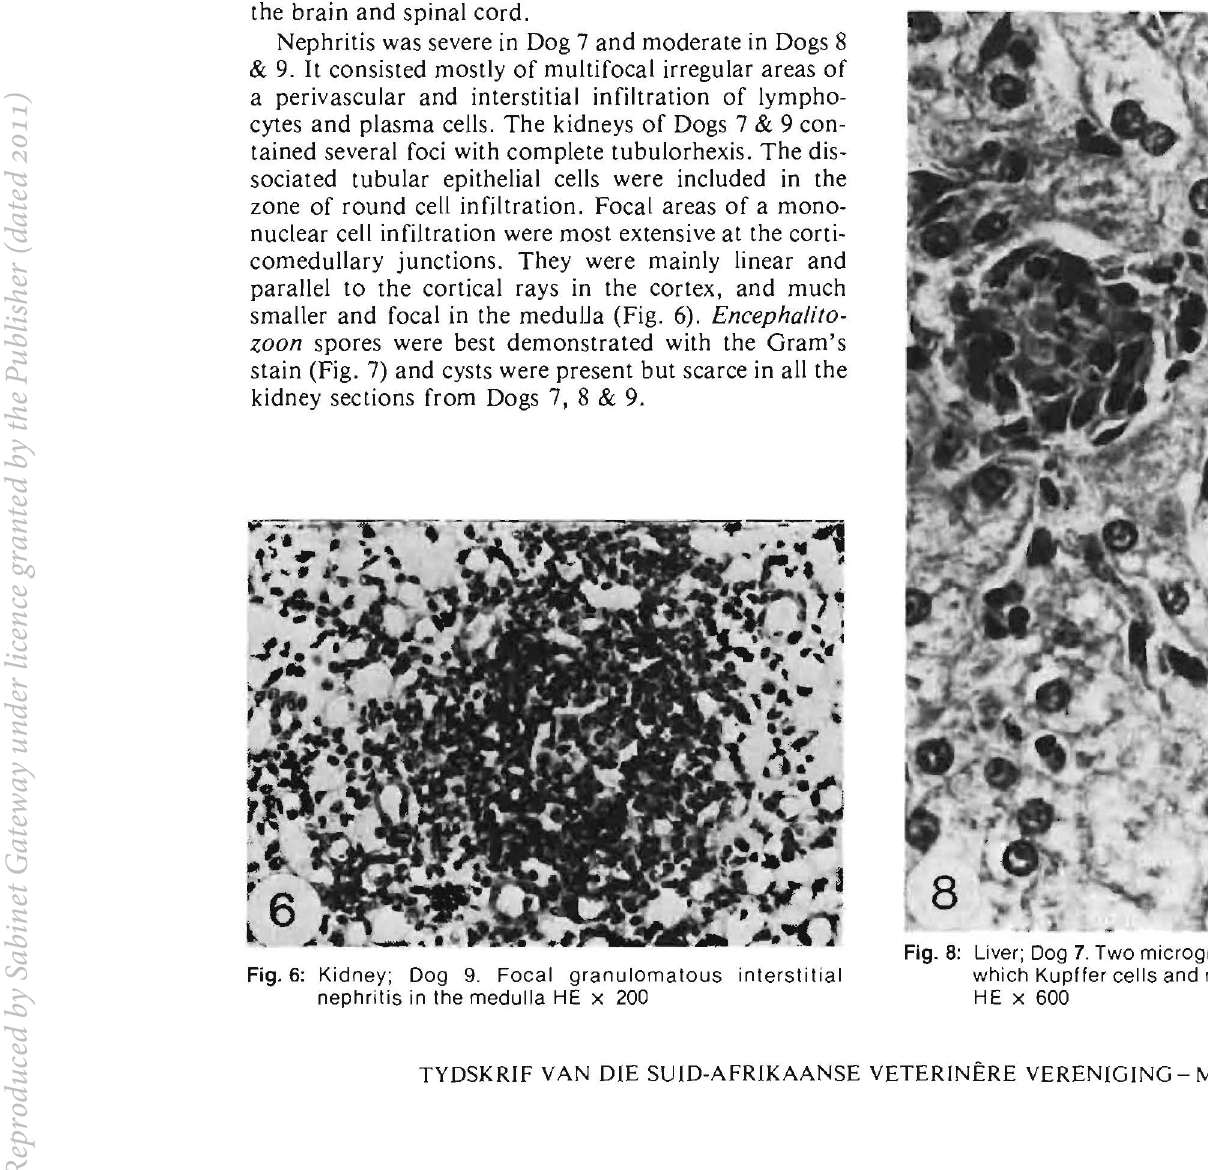
Fig. 6: Kidney; Dog 9. Focal granulomatous interstitial nephritis in the medulla HE x 200